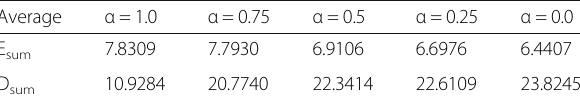
Table 1 Average values of geometric entropy and distances of the selected streamline pairs Average